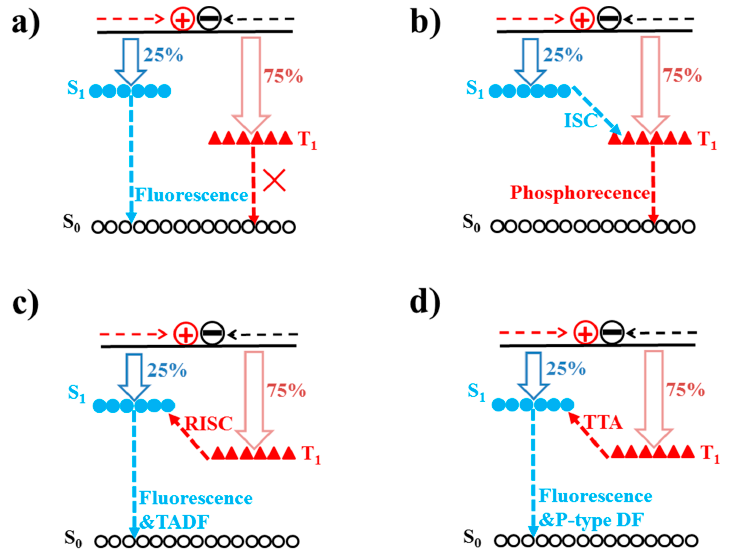
Figure 2. Exciton energy diagram and the possible decay ways of singlet and triplet excitons. T 1 , S 1 and S 0 represent the triplet energy, singlet energy, and ground state, respectively. ( a ) Fluorescence in conventional fluorescent emitters; ( b ) Phosphorecence in phosphorescent emitters; ( c ) Fluorescence and (thermally activated delayed fluorescence) TADF emitters; ( d ) Fluorescence and p-type delayed fluorescence in triplet-triplet annihilation (TTA) based emitters.